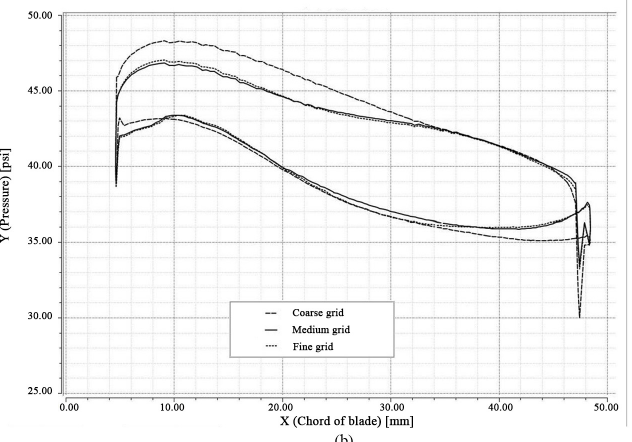
Figure 7. Grid convergence testing of CFD model. ( a ) Schematic diagram of the monitoring line; ( b ) Aerodynamic pressure of 90% of the blade span.